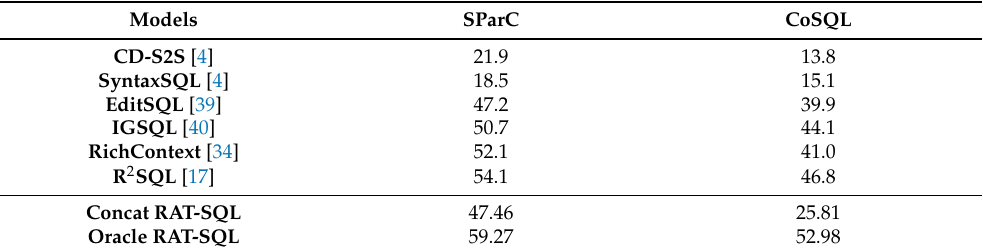
Table 4. Comparison of the two-stage framework and existing methods. Concat RAT-SQL represents the method using concatenated dialogue utterances as the inputs. Oracle RAT-SQL represents the method using the golden rewritten utterances as the inputs. The metric used in this experiment is QEM accuracy.